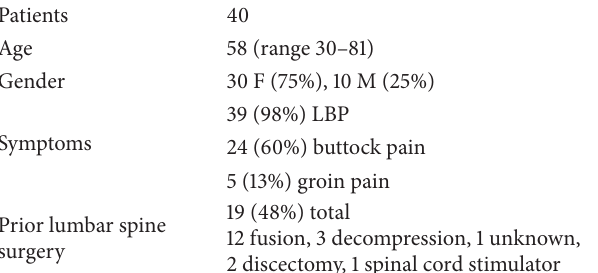
Table 1: Patient